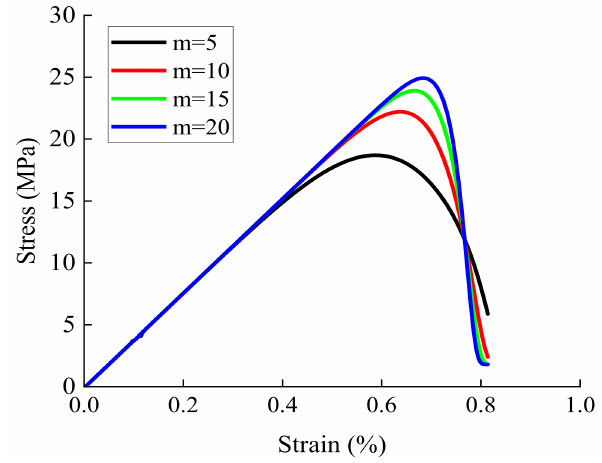
Figure 12. Sensitivity analysis of parameter m .